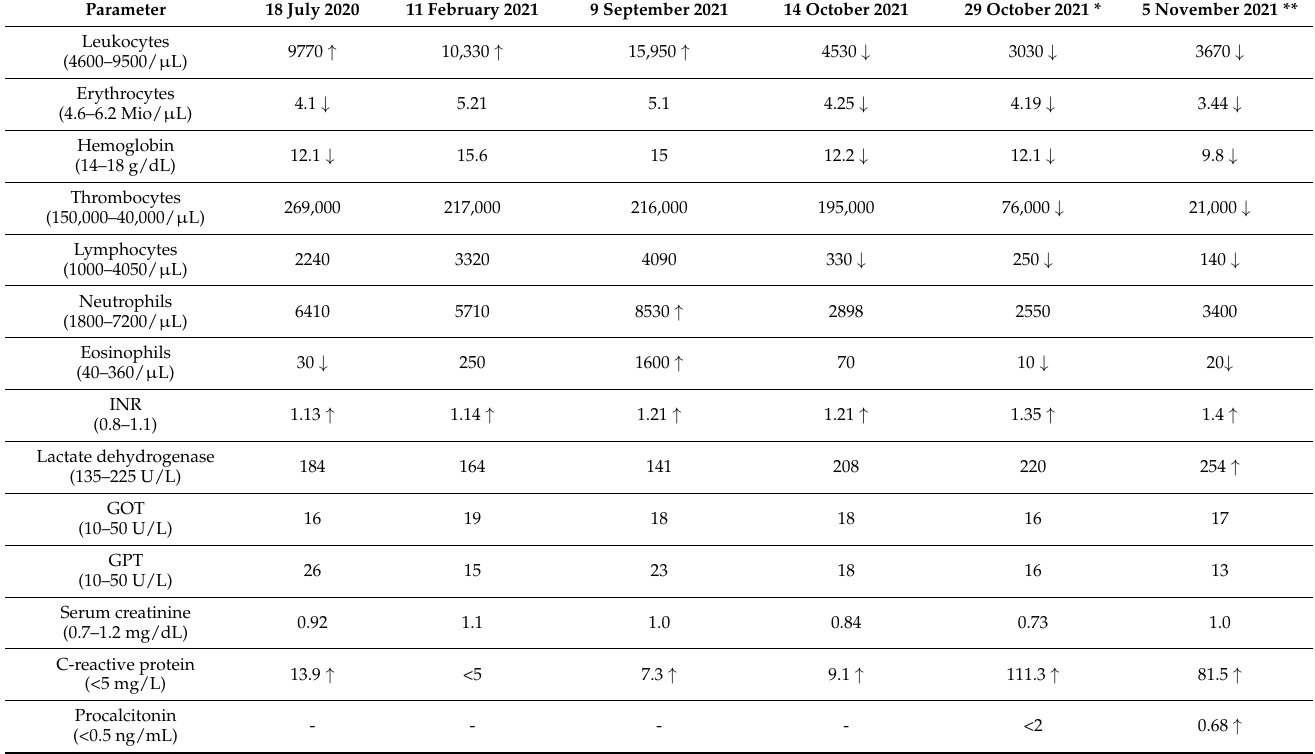
Table 1. Overview of laboratory findings from July 2020 to the beginning of November 2021 in a patient with paraneoplastic autoimmune multiorgan